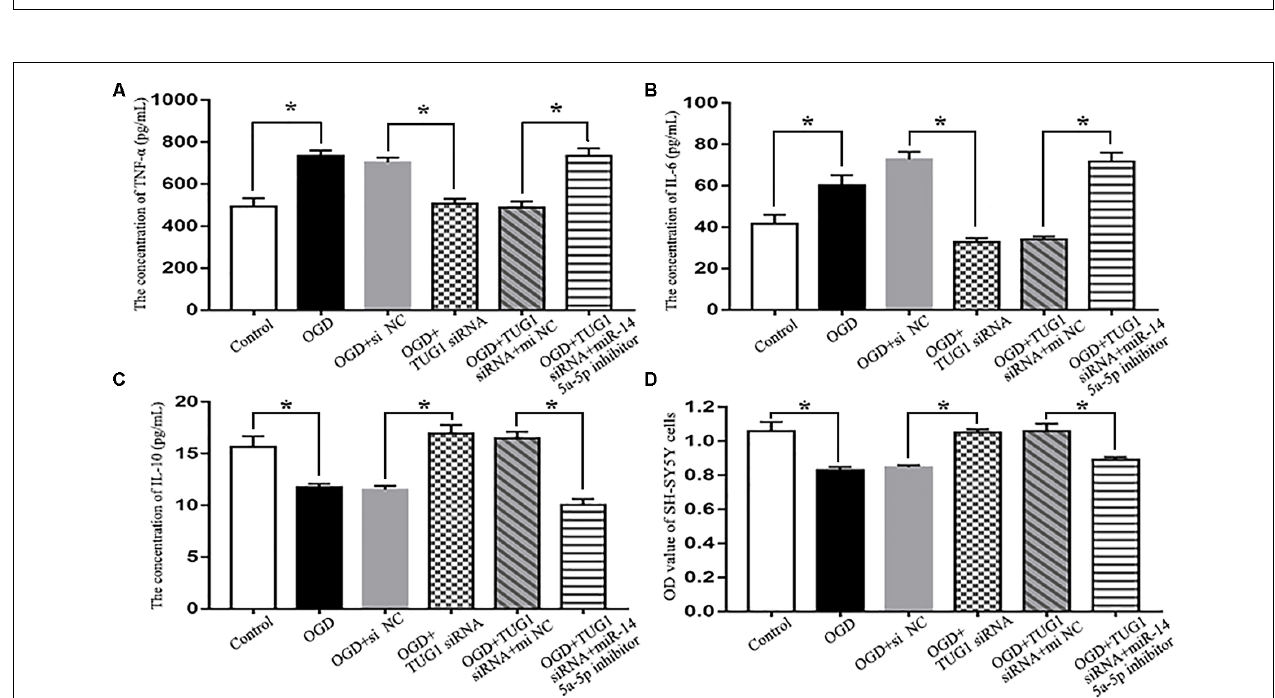
FIGURE 4 | Cytokine detection by ELISA and cell viability assay by CCK-8. TUG1 knockdown suppressed the production of tumor necrosis factor- α (TNF- α ; A ) and interleukin-6 (IL-6; B ) while elevated the concentration of interleukin-10 (IL-10; C ) after OGD, with enhanced SH-SY5Y cell viability after OGD (D) . The effects of